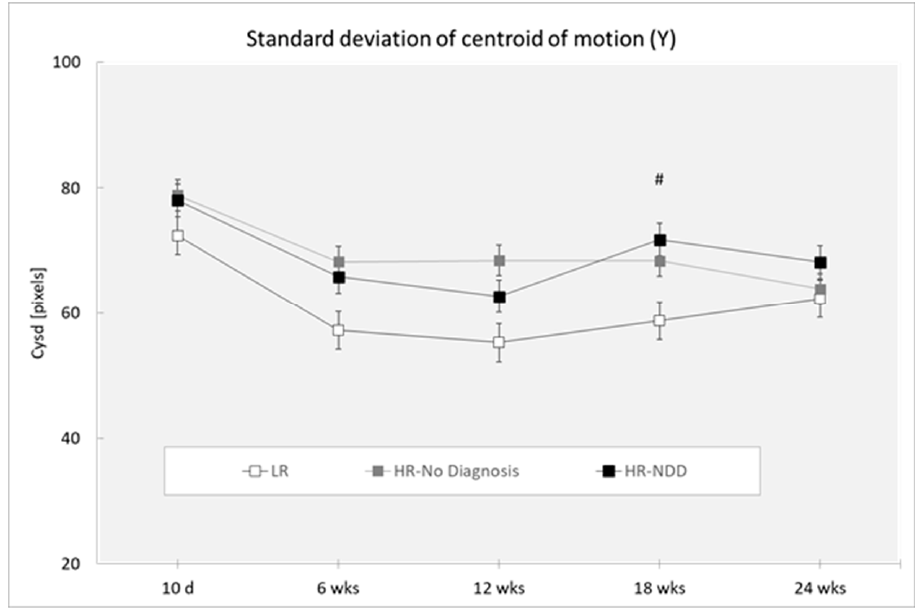
Figure 4. Standard deviation of centroid of motion in Y direction (Cxsd) in a 3-min session, measured at 10 days and 6, 12, 18, and 24 weeks in three groups of infants (LR, n = 53; HR-no diagnosis, n = 32; HR-NDD infants, n = 18). d = days; wks = weeks. Data are expressed as mean ± SEM. # p < 0.05 between HR-no diagnosis and LR infants.